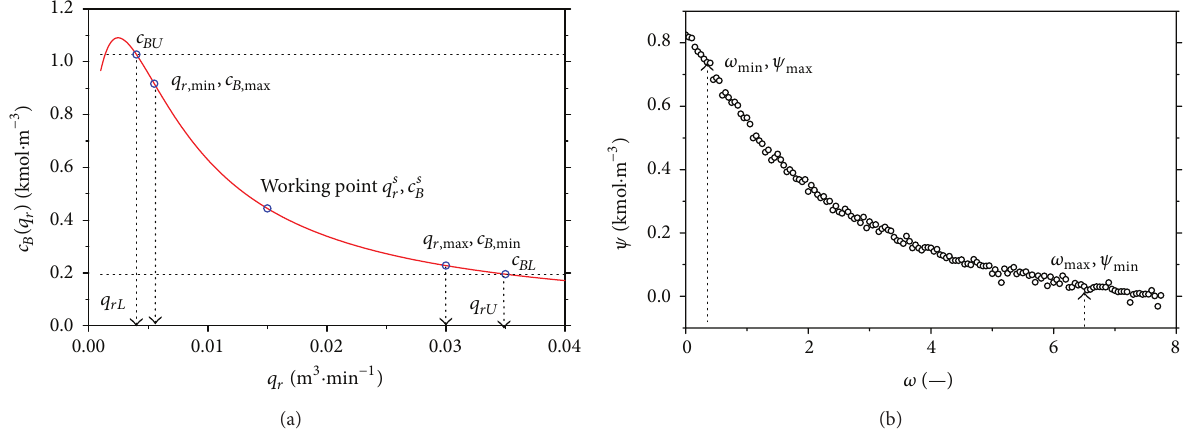
Figure 7: The steady-state characteristic (a) and noised data in new coordinates 𝜓 = 𝑓(𝜔) (b).